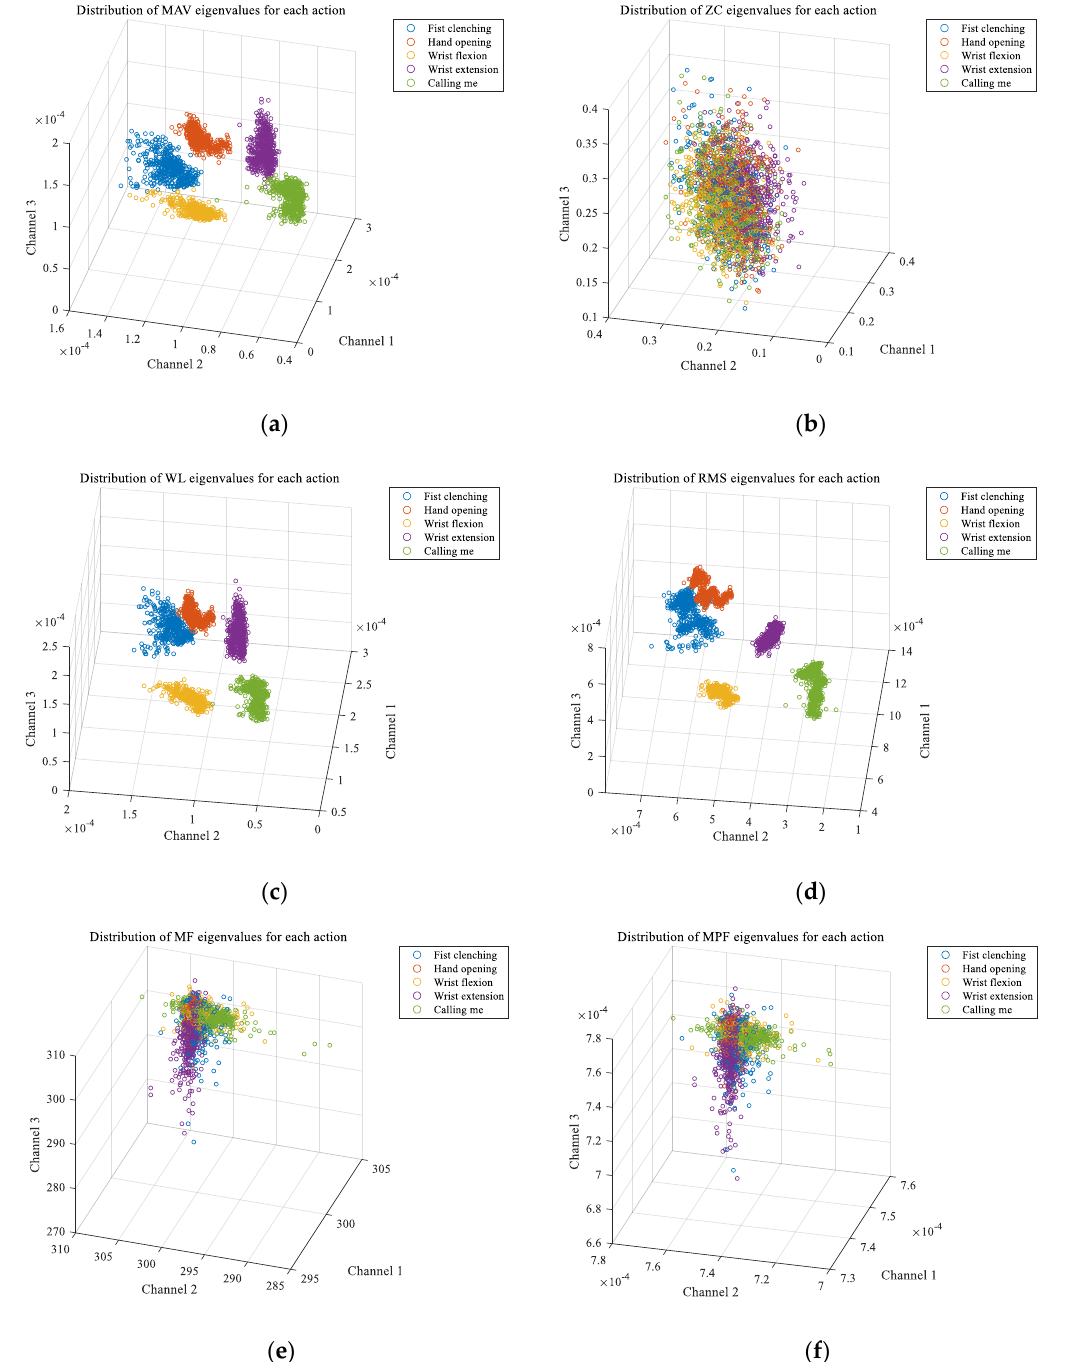
Figure 6. Spatial distribution of each feature. ( a ) MAV, ( b ) ZC, ( c ) WL, ( d ) RMS, ( e ) MF, and ( f ) MPF. The x, y, and z labels are channel 1, 2, and 3. The actions represented by different colors are marked — the blue points represent fist clenching, the red points represent hand opening, the yellow points represent wrist flexion, the purple points represents wrist extension, and the green points represents calling me. The classification effect is better if the difference can be seen with the naked eye. Or if it is difficult to distinguish the scattered points, the classification effect is poor.